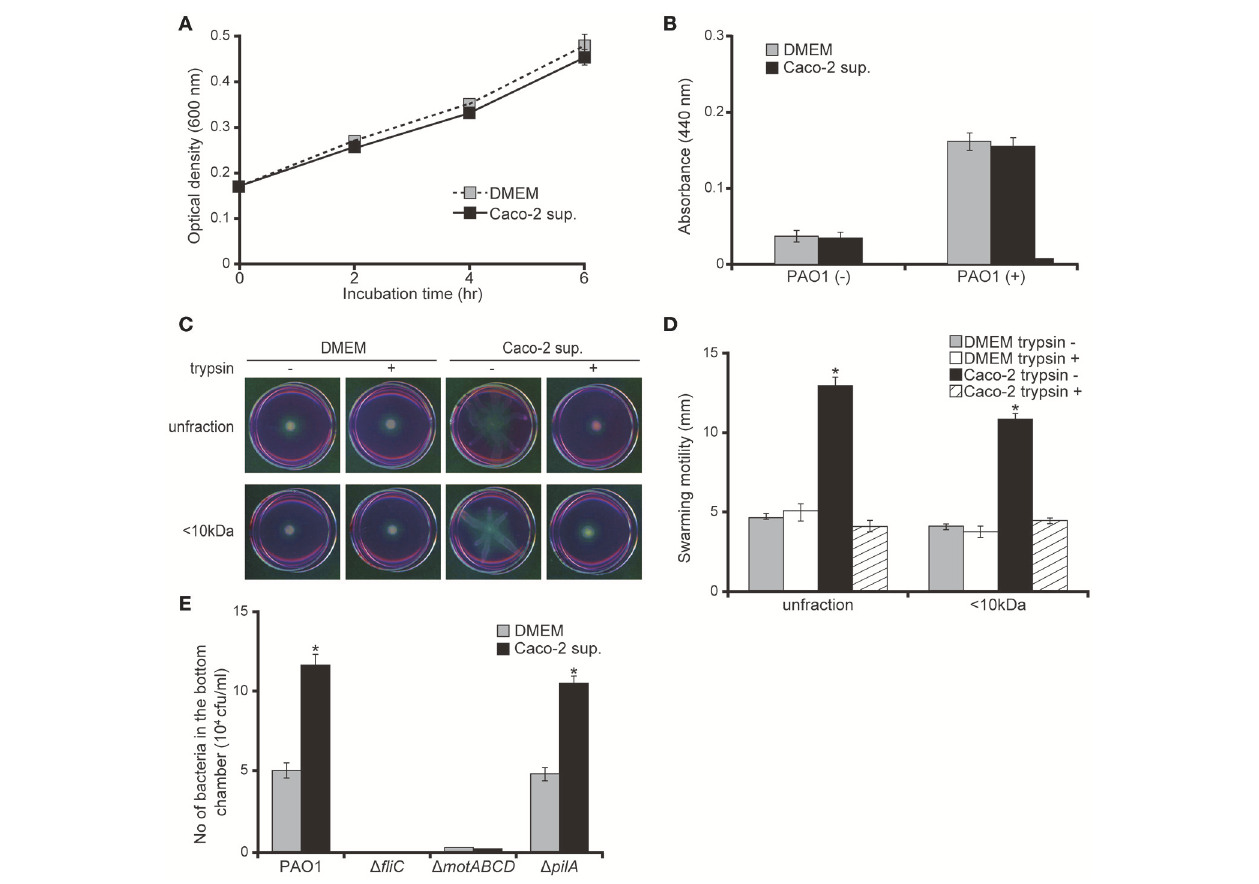
FIGURE 3 | Caco-2 cell supernatant facilitates a swarming motility of the P. aeruginosa PAO1 strain. (A) The P. aeruginosa PAO1 strain was incubated in Caco-2 cell supernatant (Caco-2 sup.) or Dulbecco’s modified Eagle medium (DMEM; control) at 37 ◦ C in 5% CO 2 . After incubation, the optical density (600 nm) of the culture was measured at the indicated times. Error bars indicate standard error ( n = 3). (B) After incubation of the P. aeruginosa PAO1 strain in Caco-2 cell supernatant (Caco-2 sup.) or DMEM (control) at 37 ◦ C in 5% CO 2 for 5 h, the azocasein degradation activity of the collected culture supernatant was measured. Error bars indicate standard error ( n = 3). (C) A 15-day Caco-2 cell supernatant (Caco-2 sup.) and DMEM (control) were filtered through 10-kDa MW cut-off membranes. The < 10 kDa fraction and unfiltered samples were treated with or without trypsin (trypsin + or − ). The P. aeruginosa PAO1 strain was spotted on swarming agar containing the treated samples. After incubation for 14 h, the swarming agar plates were observed and photographed. (D) The radial distance (mm) from the center of the agar was measured. Error bars indicate standard error ( n = 3). * P < 0.05 compared with DMEM at the same size fraction. (E) A 15-day Caco-2 cell supernatant (Caco-2 sup.) or DMEM (control) was filled in the bottom chamber of Transwell. The P. aeruginosa PAO1 strain, flagellar mutants ( 1 fliC and 1 motABCD ), or a type IV pilus mutant ( 1 pilA ) were added to the top chambers, and after 3 h, the numbers of bacteria in the bottom chambers were counted. Error bars indicate standard error ( n = 3). * P < 0.05 compared with incubation in DMEM of the same